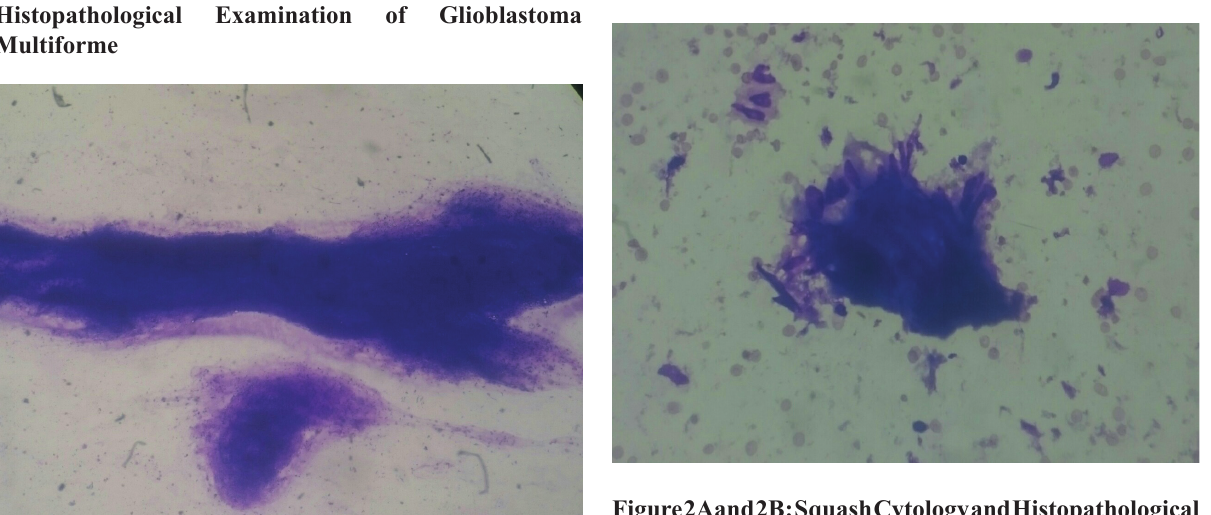
Figure 1 B: Tissue Section GBM: Diffuse proliferation of polygonal to elongated tumor cells with marked pleomorphism. and endocapillary proliferation seen.